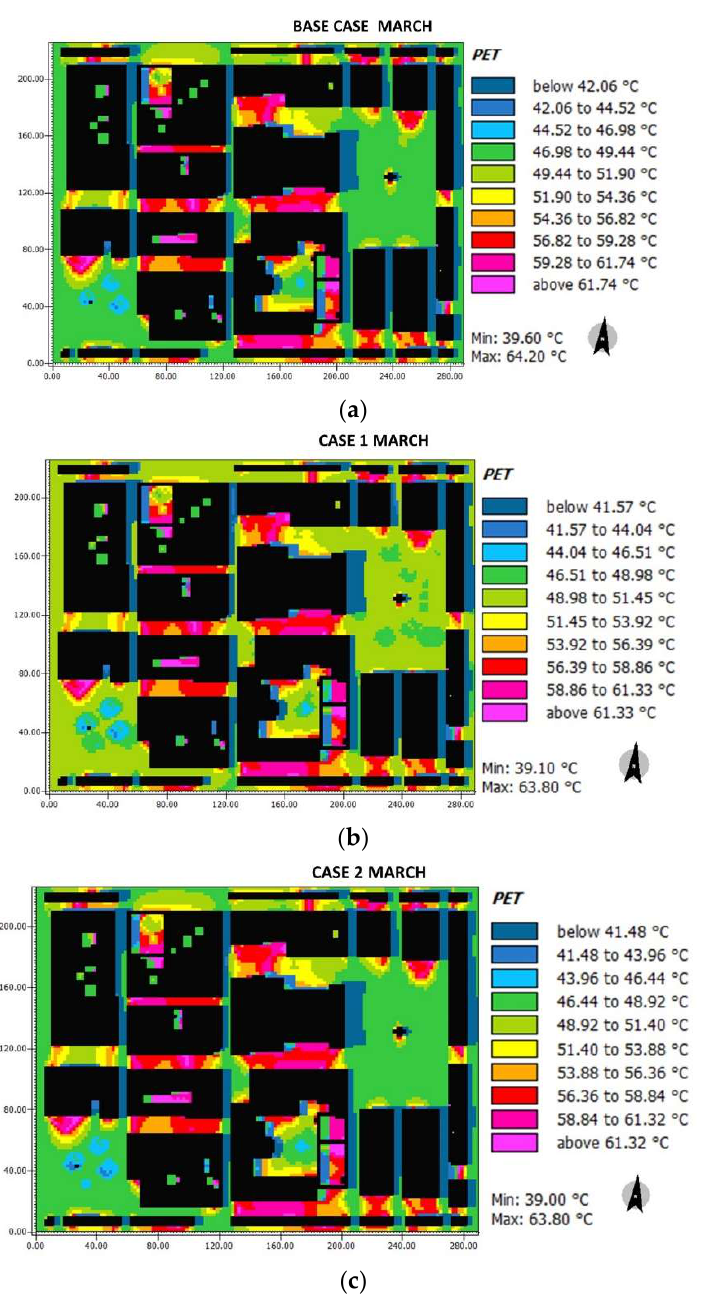
Figure 15. Results maps for pet for March at 15:00: ( a ) base case, ( b ) case 1, and ( c ) case 2. For the PET comfort index in October (Figure 16), the base case ranges between 36.17 °C and 47.92 °C and 39.1 °C and 56.73 °C for Herrera and Cathedral squares, respectively. The horizontal streets (H, G1, G2, G3, I) present a range of 44.98–47.92 °C unlike the vertical ones (A, B, C, D, E), in which, due to the generated shadow, lower values are found (36.17–39.1 °C). For case 1, in Herrera square, the PET oscillates between 35.72–50.43 °C, for the Cathedral square (38.66–56.02 °C), and the horizontal streets (H, G1, G2, G3, I) (44.45–47.34 °C) and for the vertical streets (35.77–41.56 °C). Finally, for case 2, in both squares, the PET values oscillate between 35.77–47.34 °C; the streets H, G1, G2, G3, I, the